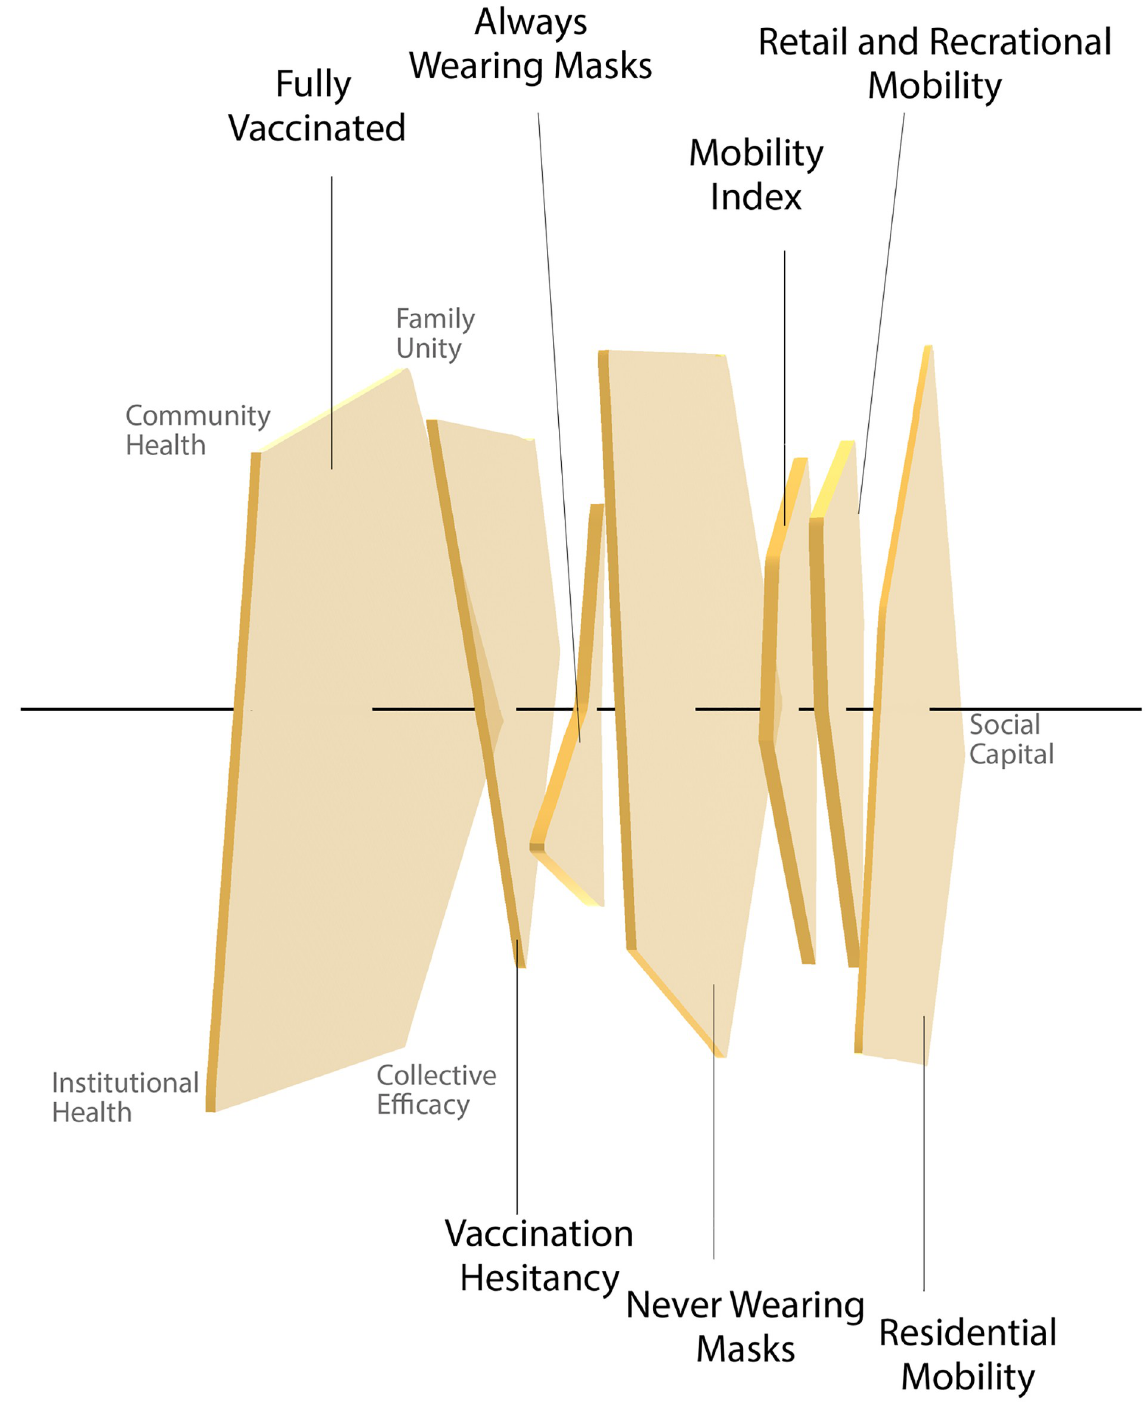
Fig 2. A Swiss cheese model for social capital, with pentagons representing the five social capital indices’ impact on social behaviors.